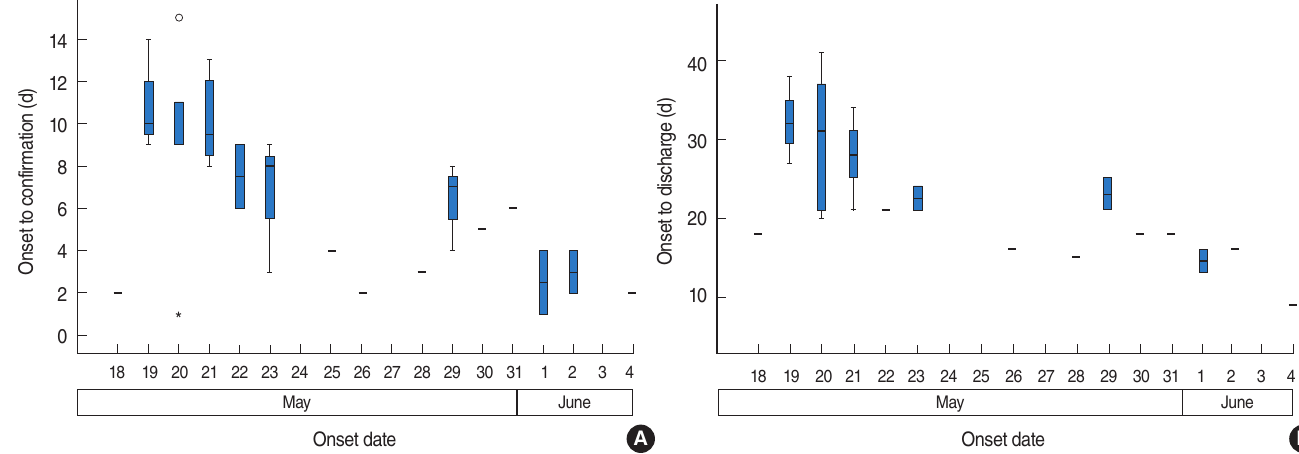
Figure 2. Duration from MERS symptom onset to confirmation (A) and discharge (B) by onset date, Pyeongtaek St. Mary’s Hospital,